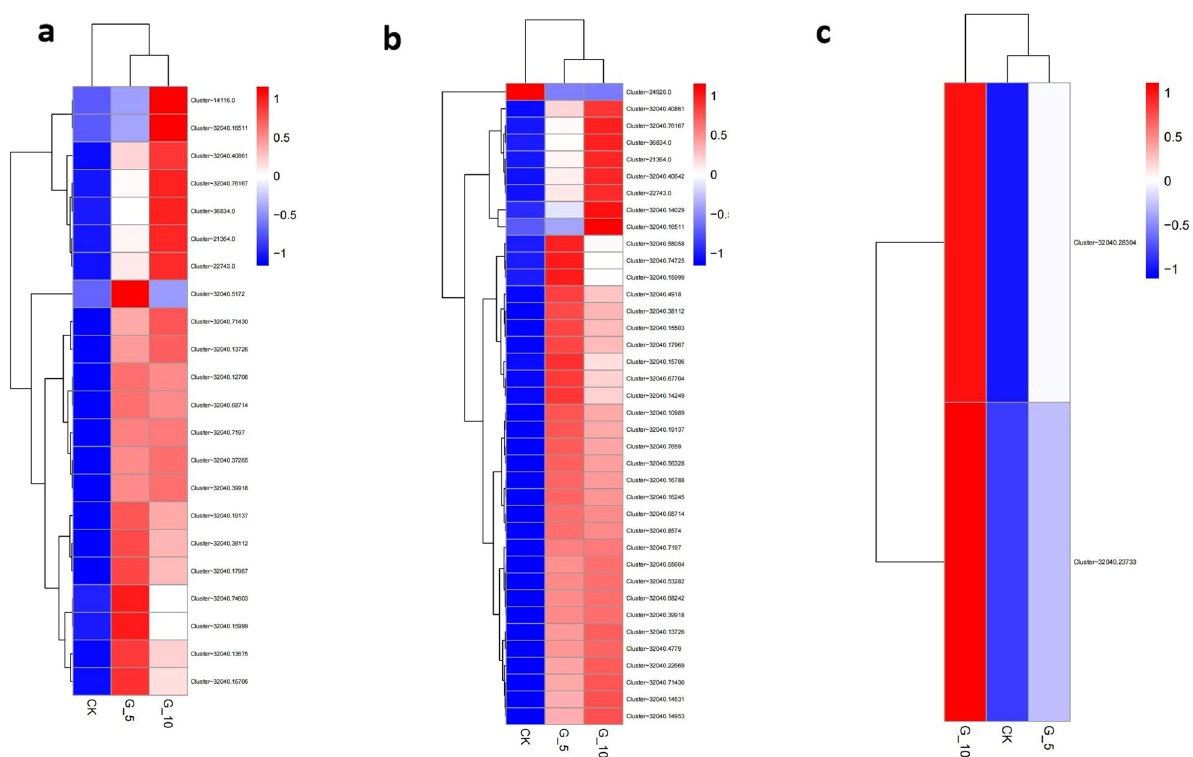
Figure 8. The unigenes involved in ME-IAA, IP, and ACC. ( a ) The expression of unigenes involved in ME-IAA. ( b ) The expression of unigenes involved in IP. ( c ) The expression of unigenes involved in